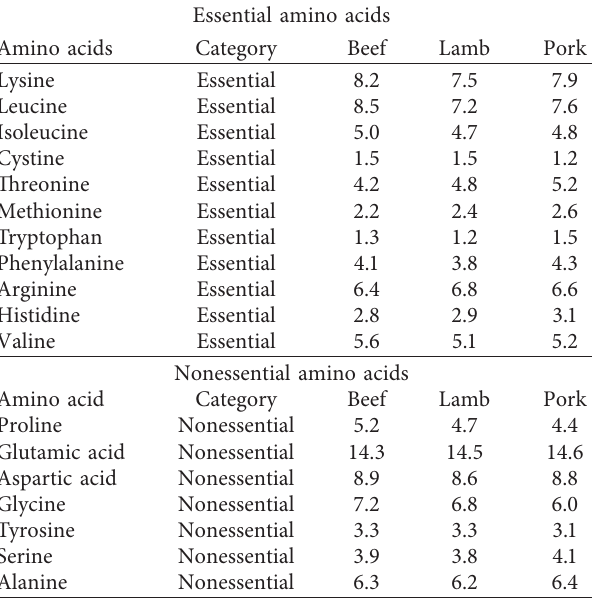
Table 2: Nutritional composition of meat.